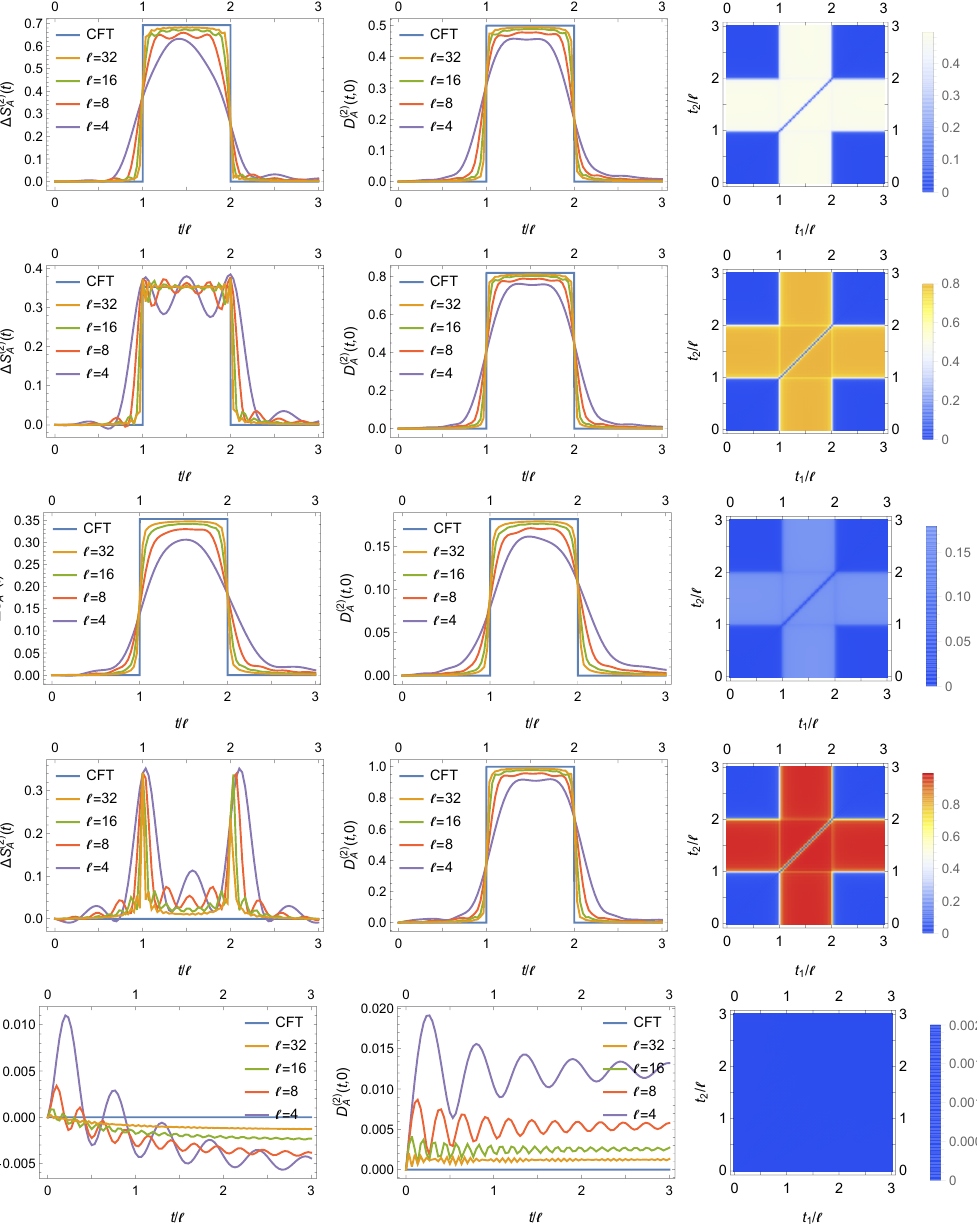
Figure 6 . Local operator quench in the linearized critical Ising spin chain. From top to bottom, we consider the states locally excited by d 2 j , d 2 j (cid:0) 1 + d 2 j , d 2 j (cid:0) 1 (cid:0) d 2 j , ( j (cid:0) 1 states we have respectively q = 1 and Schatten distance. In the 3rd column we report the color plots of the Schatten 2-distance between RDM at generic times D A ( t 1 ; t 2 ) with ‘ = 32.